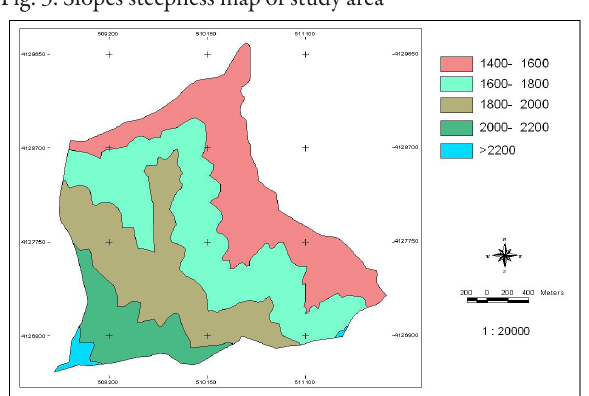
Fig. 8. Thymus-Festuca community